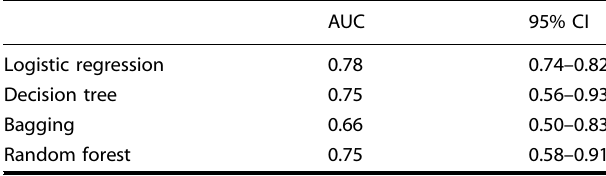
Table 4. Comparisons of AUCs between four prediction models.